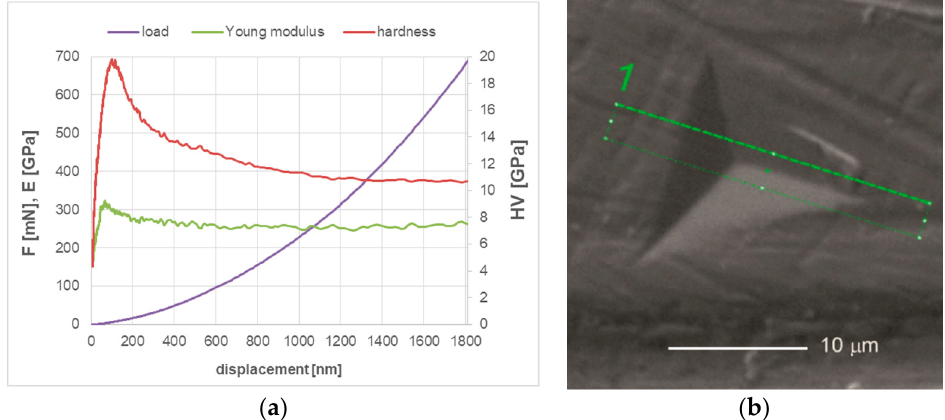
Figure 4. ( a ) Mechanical properties of the coating on M2 steel in as –deposited state, determined in nanoindentation test performed in continuous stiffness mode, ( b ) SEM image of the surface of the coating after indentation (in a single indentation mode, max. load. 150 mN), with marked area for thin foil preparation for TEM observations by FIB.